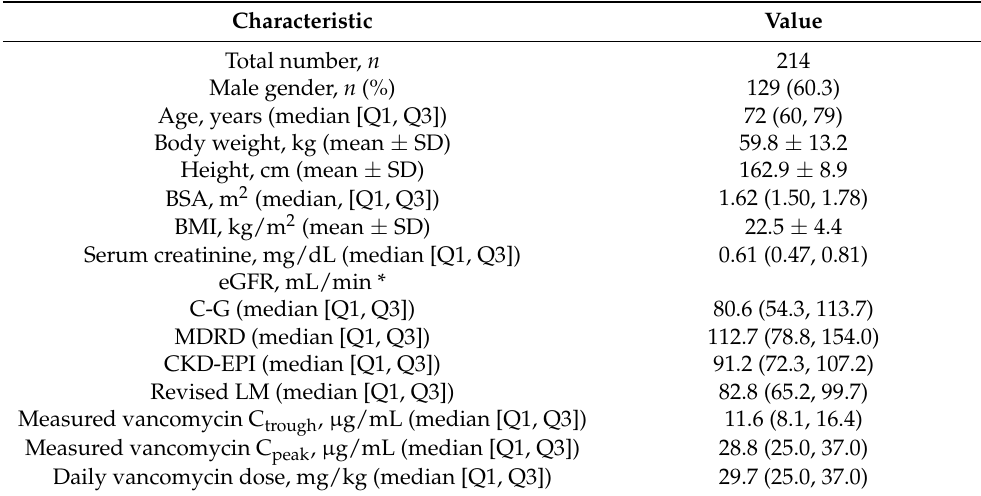
Table 1. Characteristics of the study population.